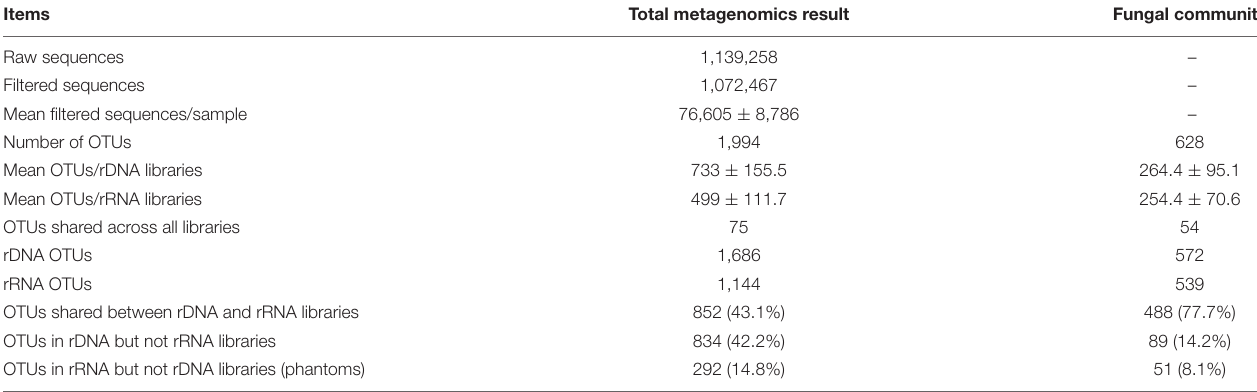
TABLE 1 | Sequence summary statistics based on 18S rDNA and rRNA